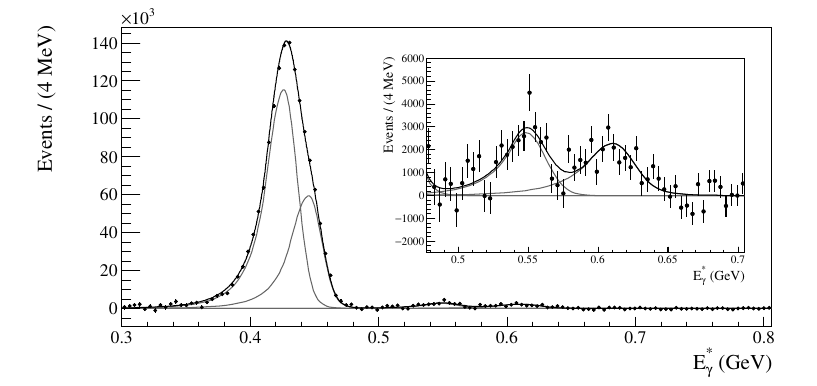
Figure 1. The inclusive photon spectrum after subtraction of the background component of the fit. The black curve indicates the fit to the data, and the gray curves indicate the individual signal components. The χ b 1 , 2 (1 P ) → γ Υ (1 S ) transitions at ∼ 424 and ∼ 442 MeV are dominant. The inset contains the same information with the scale chosen to highlight the ISR and η b (1 S ) signal peaks, appearing at ∼ 550 and ∼ 600 MeV,